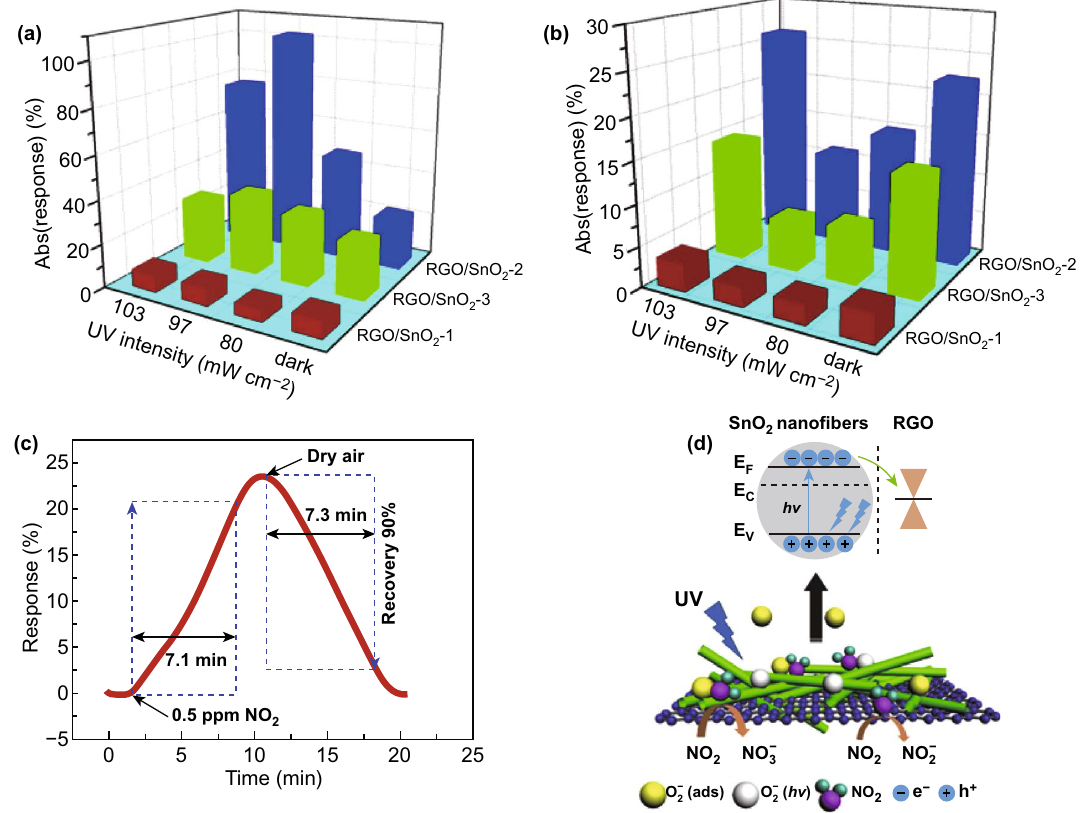
Fig. 6 UV intensity-dependent response absolute value based on rGO/SnO 2 sensors in a 3 ppm NO 2 and b 30 ppm SO 2 . c Enlarged part of response–recovery cureves of rGO/SnO 2 sensor to 0.5 ppm NO 2 . d Sensing mechanism of rGO/SnO 2 to NO 2 under UV illumination. Repro- duced with permission [74]. Copyright 2019,